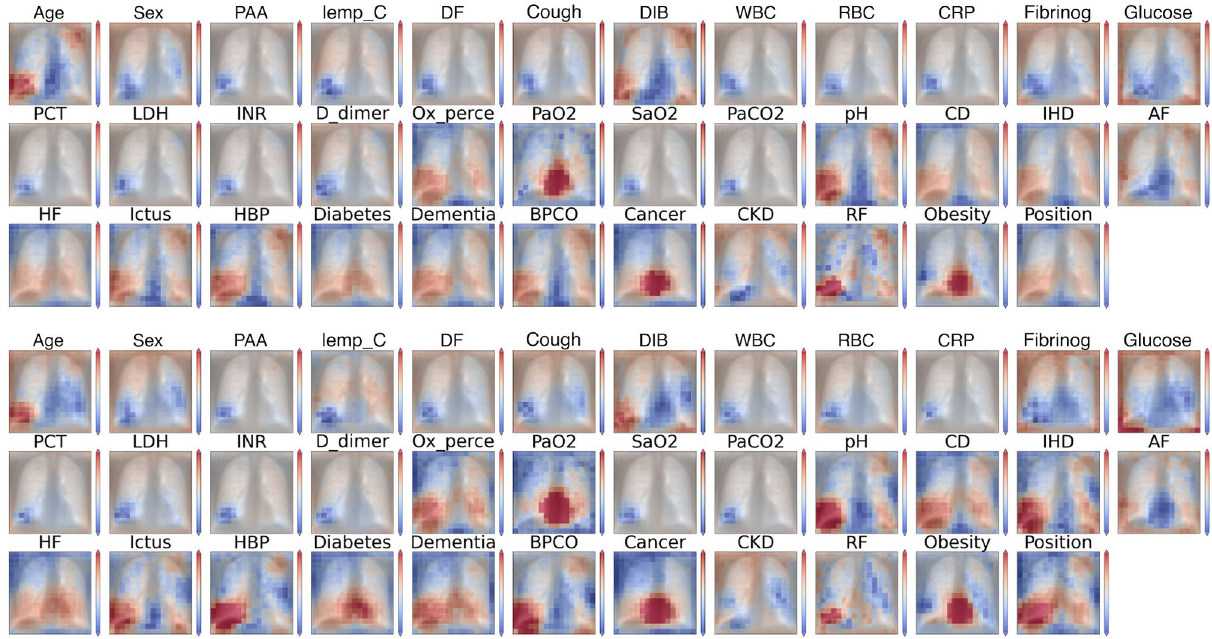
Figure 8. (top) Mean severe and mild prognosis difference attention maps on one of the validation sets (bottom) mean severe and mild prognosis difference attention maps on the test data, both having the mean lungs superimposed behind them. It can be seen that the average difference between severe and mild prognosis attentions is approximately the same for the validation and testing datasets, however, the test set distribution is not completely aligned with the validation set, therefore there are more extreme values in the attention differences. Being more red means higher severe attention, whilst being blue means a higher value of mild attentions. We can observe that given a severe prognosis, higher attention is put on the hearth and the lower lobes of the lungs in general with heart related metadata (HBP—high blood pressure, PaO 2 —oxygen levels, pH, obesity, IHD—ischemic heart disease